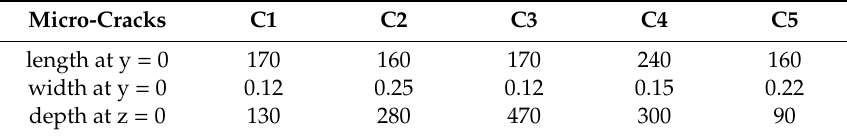
Table 1. Crack geometry (unit: mm).